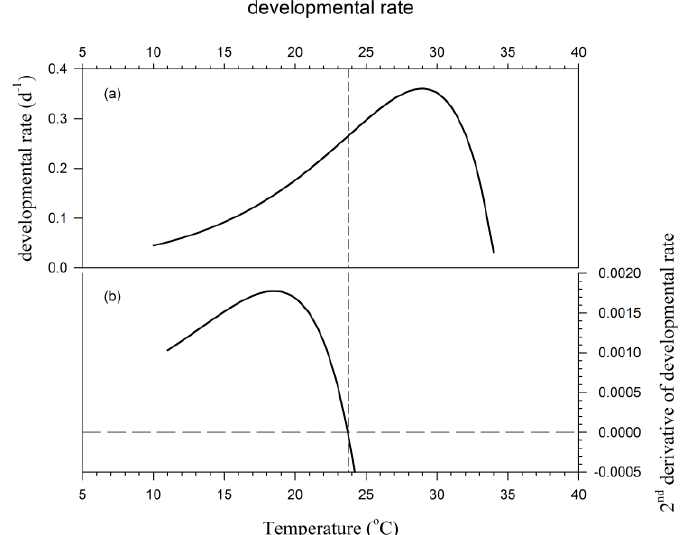
Figure 6. The vertical line indicates the temperature at which the second derivative ( b ) of a rate function ( a ) equals zero. Below this temperature, modeled daily development is less when using mean daily temperatures than when using daily minimum and maximum, or hourly temperatures. The reverse is true above this temperature.